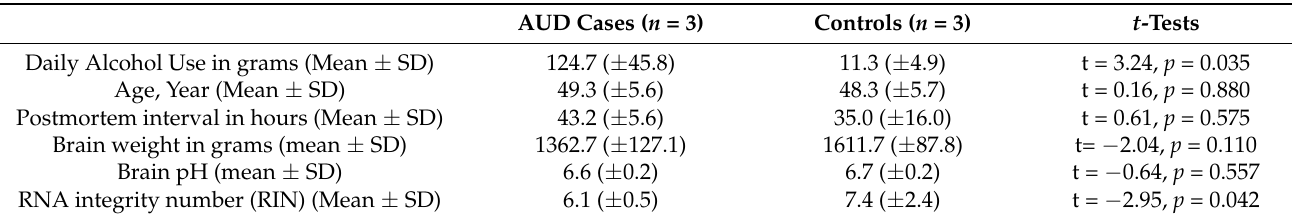
Table 1. Demographic information of postmortem nucleus accumbens (NAc) tissue samples. AUD Cases ( n =